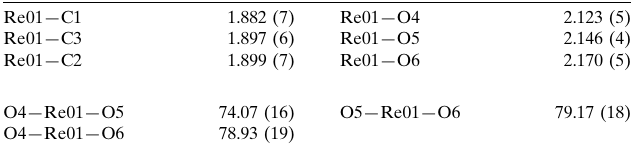
Selected geometric parameters (A˚ , (cid:2) ).